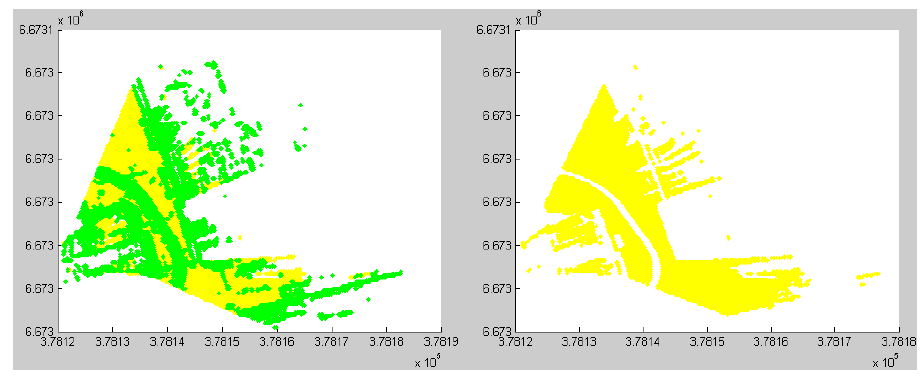
Figure 6. Ground point classification (from top view). Left : Ground points (yellow) and object points (green); Right : Ground points (yellow